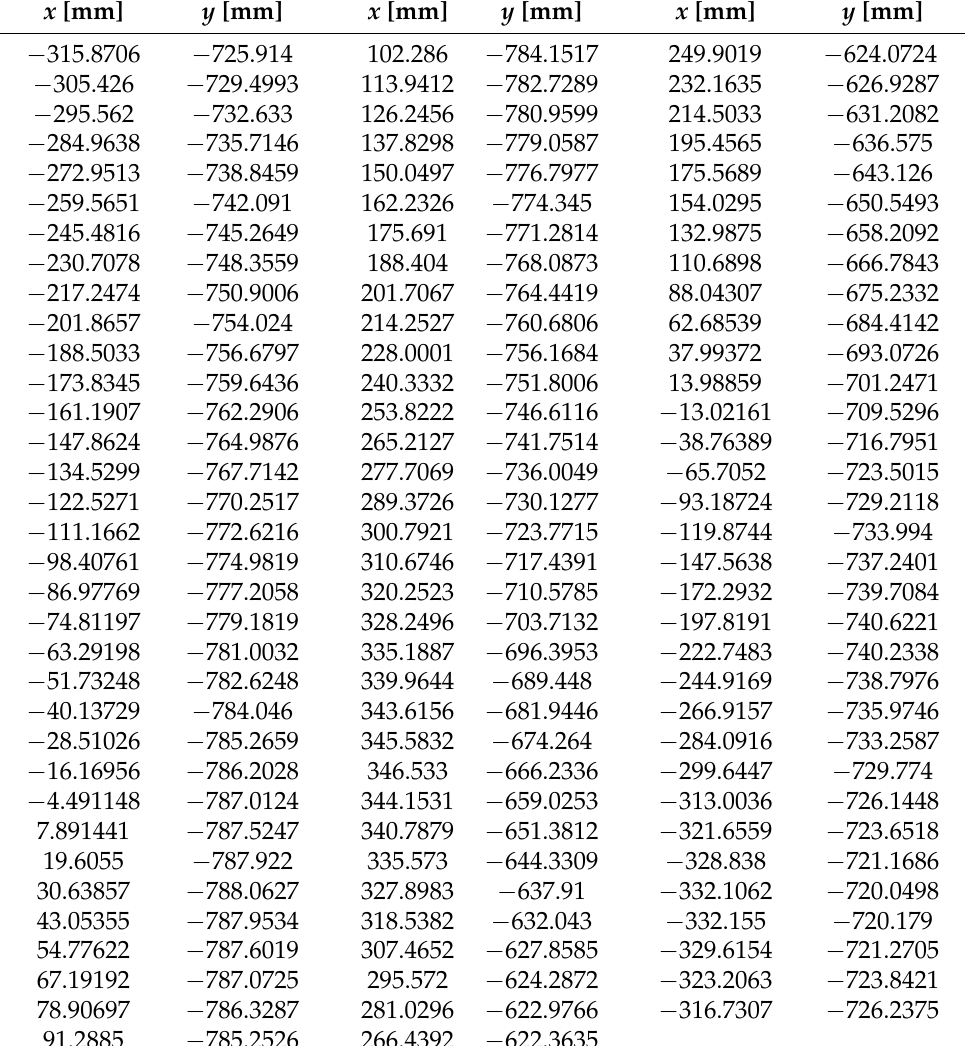
Table A2. Cartesian coordinates of the precision points for trajectory 1 in study case